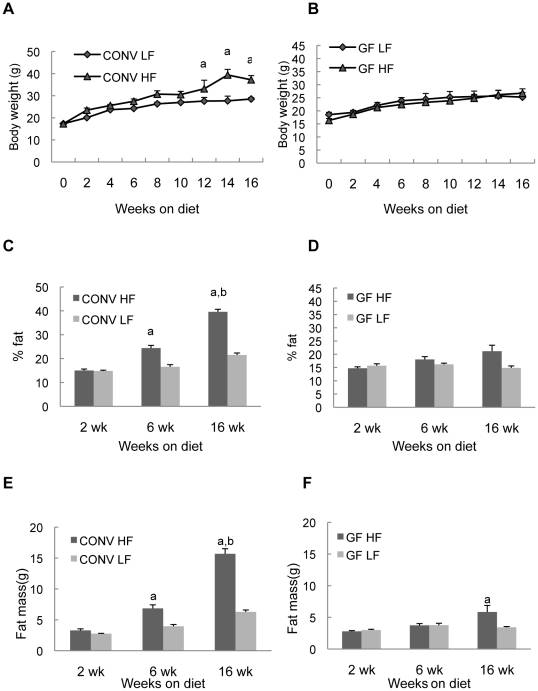
Body weight and fat mass in CONV or GF mice on HF/LF diet.Histograms show mean ± SE. a: P<0.05 vs LF group at the same time point; b: P<0.05 vs CONV HF at 2wk and 6wk.